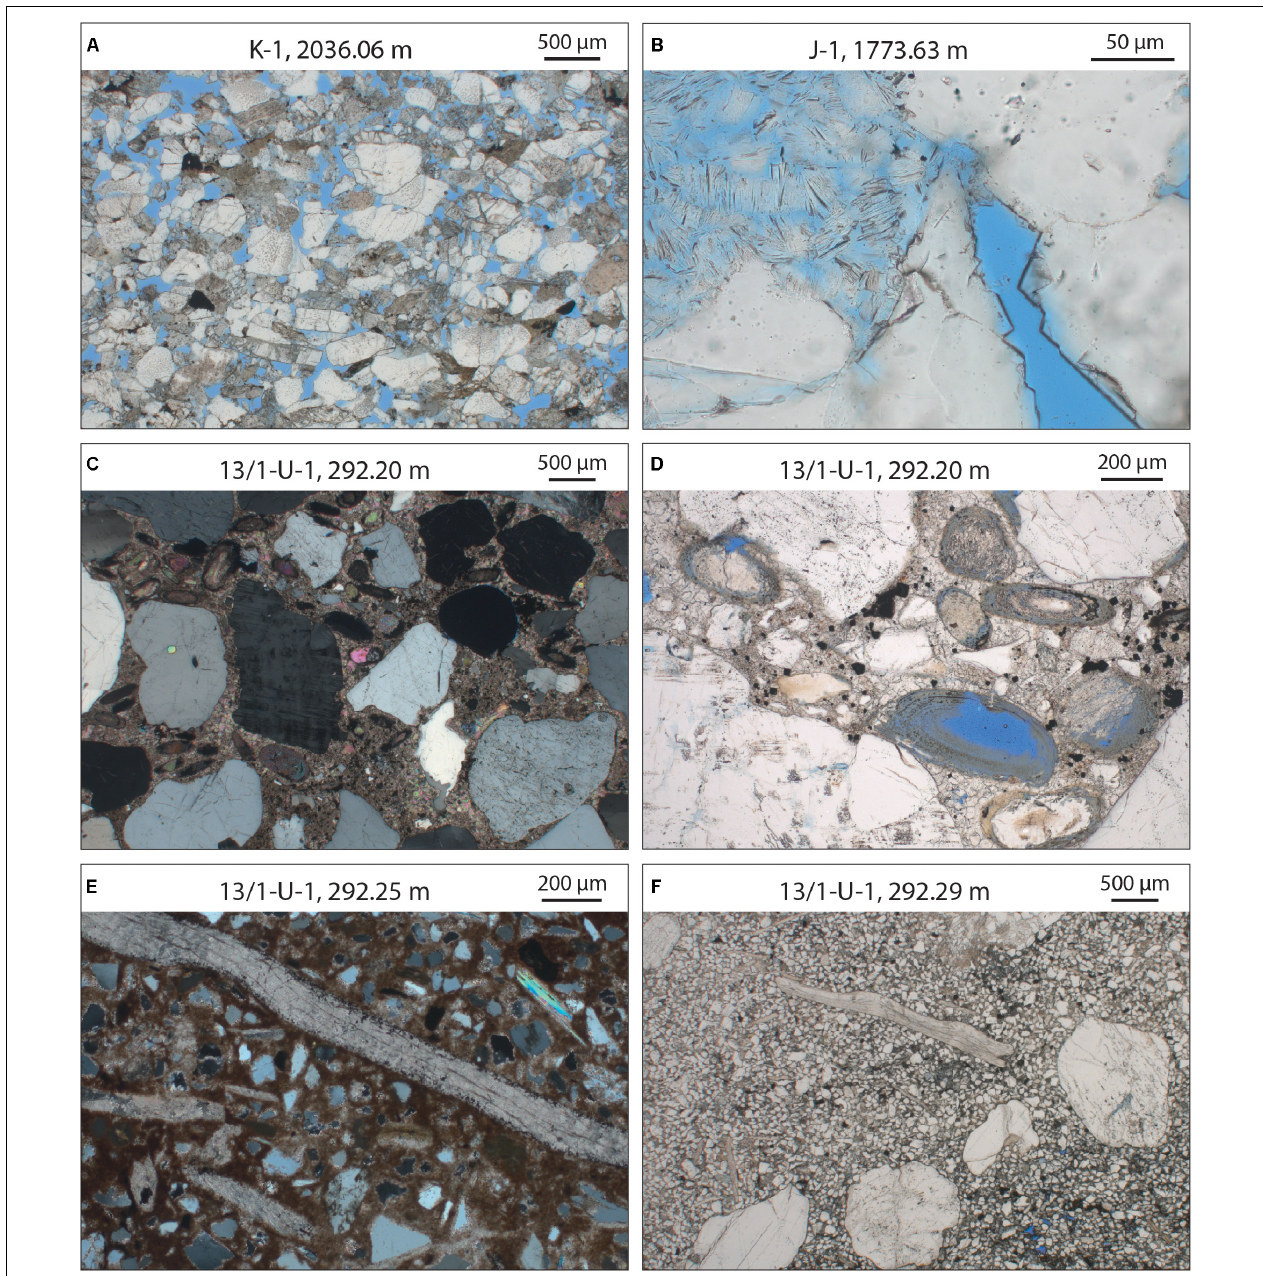
FIGURE 10 | Petrographic characteristics of the sampled sandstones. (A) Porous sandstone composed primarily of quartz and feldspar. (B) Thin quartz overgrowths enclosing kaolinite booklets. (C) Conglomerate with quartz and feldspar grains and chlorite ooids embedded in ankerite cement (crossed nicols). (D) Close-up of chlorite ooids. (E) Sandstone below the conglomerate with common shell fragments and siderite-ankerite cement (crossed nicols). (F) The lower part of the sandstone contains large grains dispersed in fine-grained sandstone with siderite-calcite